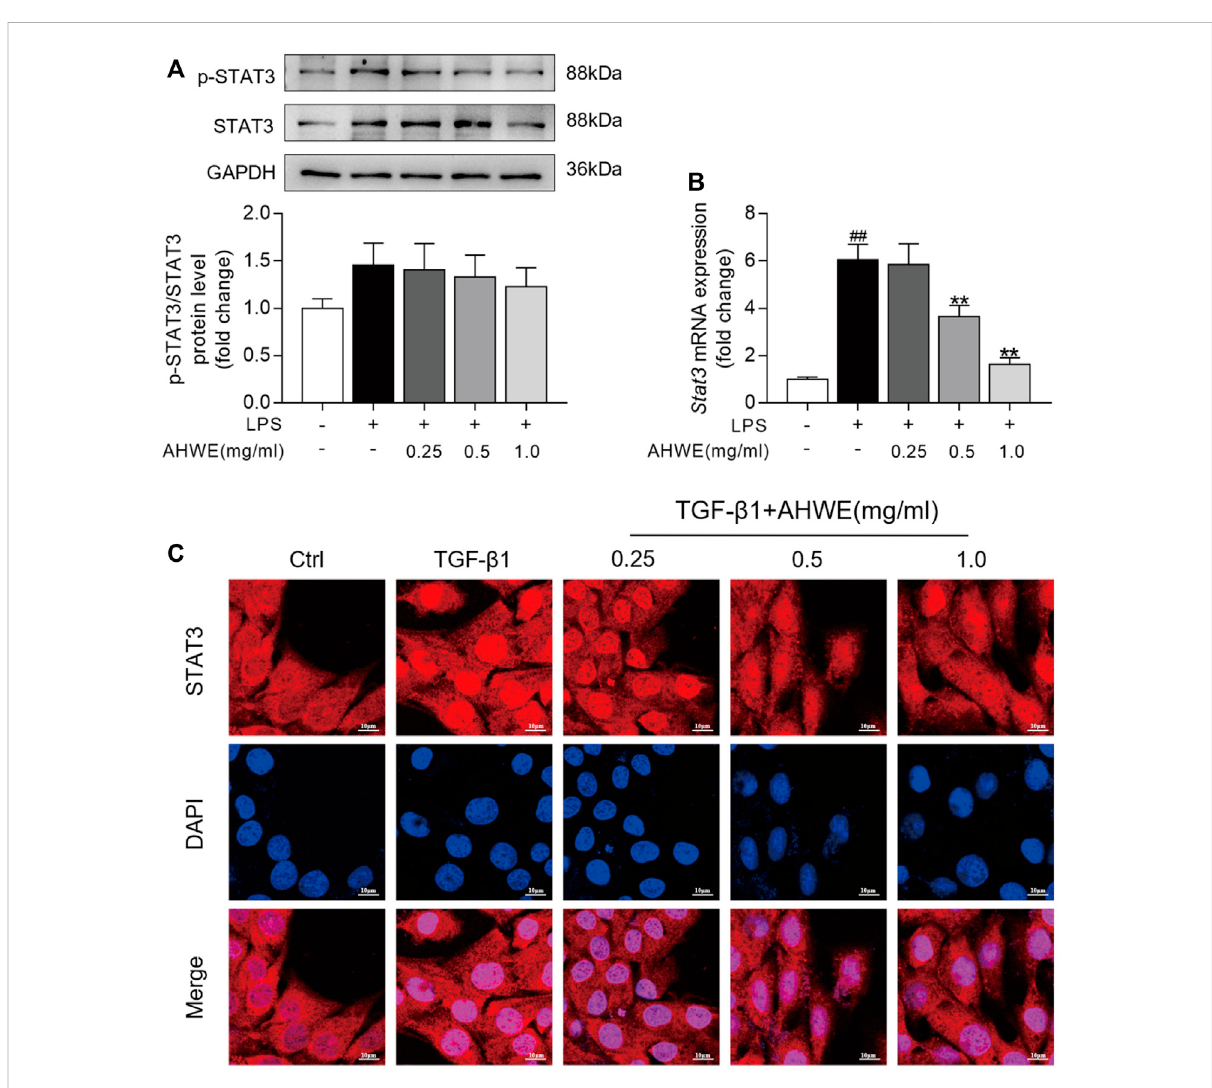
FIGURE 5 STAT3 signaling pathway might be involved into the regulation of anti fi brotic responses by AHWE. (A) Western Blotting for phosphorylated STAT3andtotalSTAT3;Densitometricanalysesofbandswerequanti fi ed,anddataexpressedasfoldofcontrolnormalizedtoGAPDH. (B) Expression of Stat3 mRNA was determined by Q-PCR. The results are representative of at least 3 independent experiments. (C) Confocal scanning images of STAT3 nucleus traf fi cking in HSC-T6 cells stimulated with TGF- β 1 (10 ng/ml) for 24 h ( n = 3), scale bar = 10 μ m. Data are expressed as mean ± SD ( n = 3). # p < 0.05 and ## p < 0.01 vs. control group; p p < 0.05 and pp p < 0.01 vs. TGF- β 1